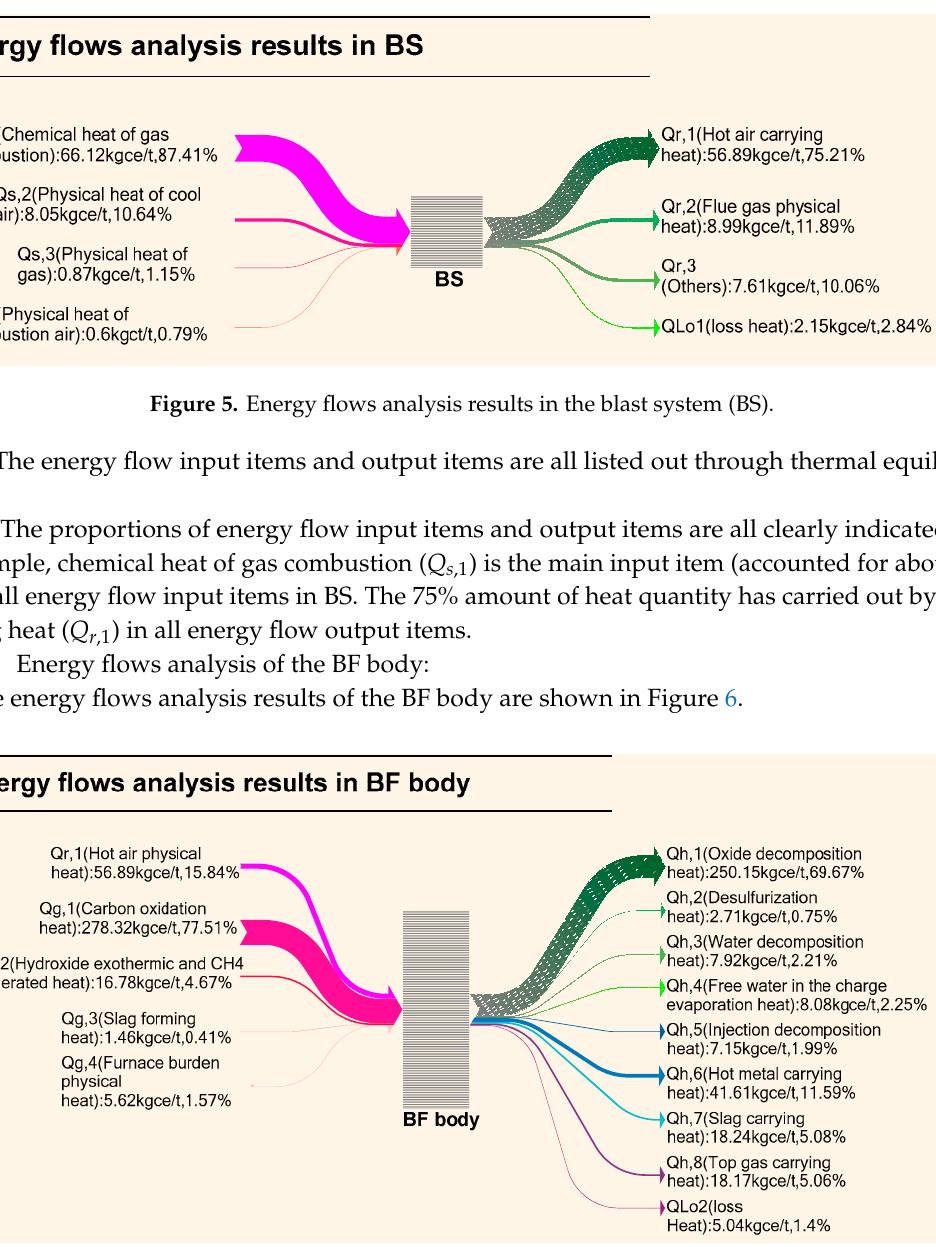
Figure 6. Energy flows analysis results in the blast furnace (BF)